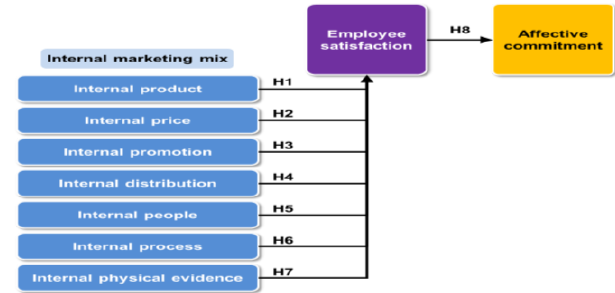
Figure 1: Proposed theoretical model Source: Researchers own